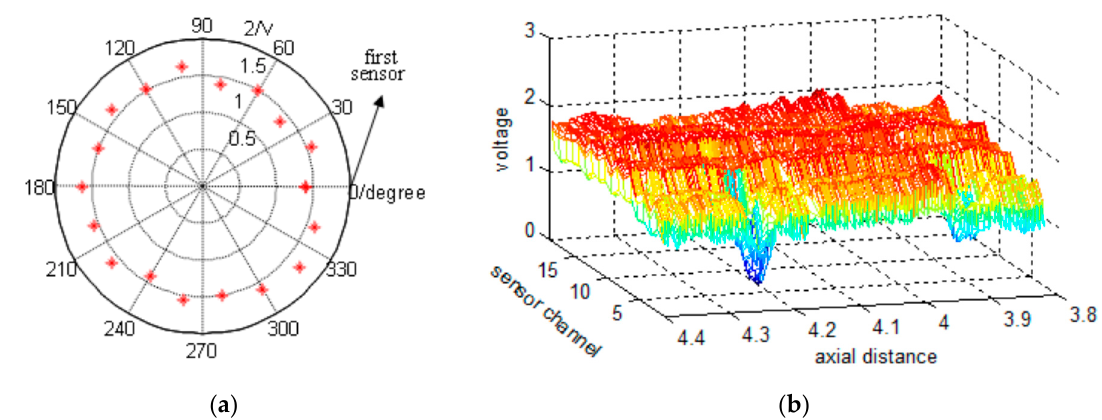
Figure 5. ( a ) The 18 circumferential data points obtained from GMR sensors for a single pulse plotted in polar coordinates (the radius represents the voltage); ( b ) Partial raw data expanded image.